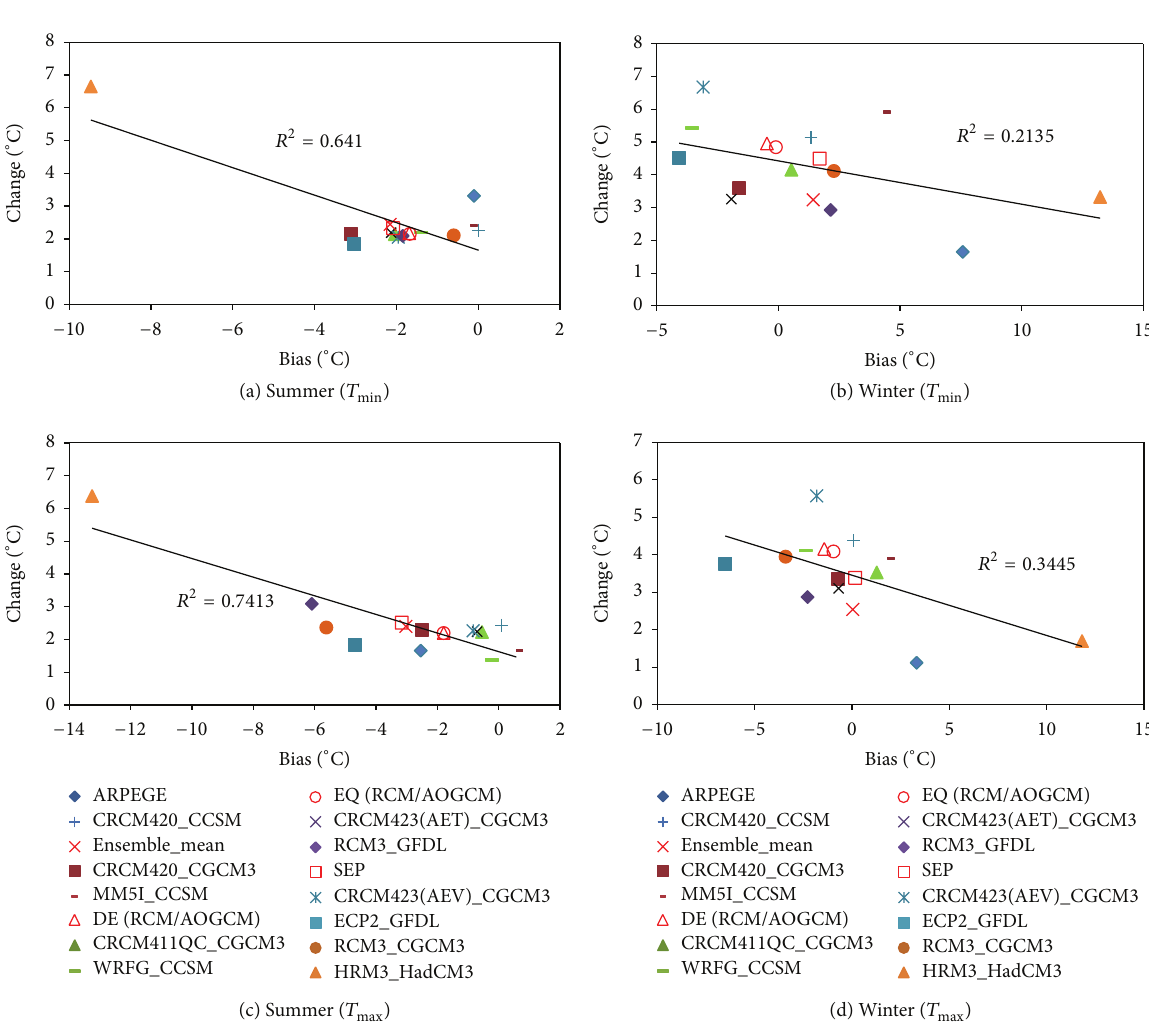
Figure 5: Same as Figure 4 but for the 10th percentile of 𝑇 min and 𝑇 max